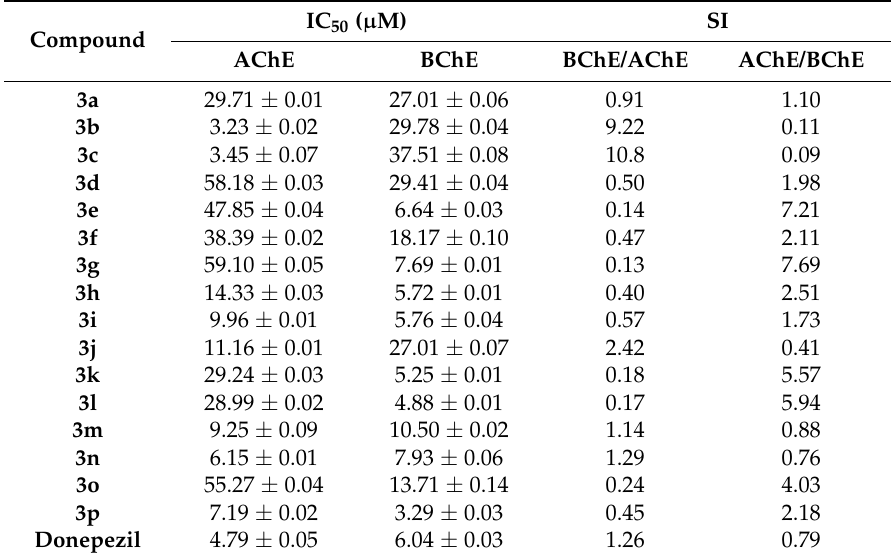
Table 3. AChE and BChE inhibitory activities of flavonols 3a – p